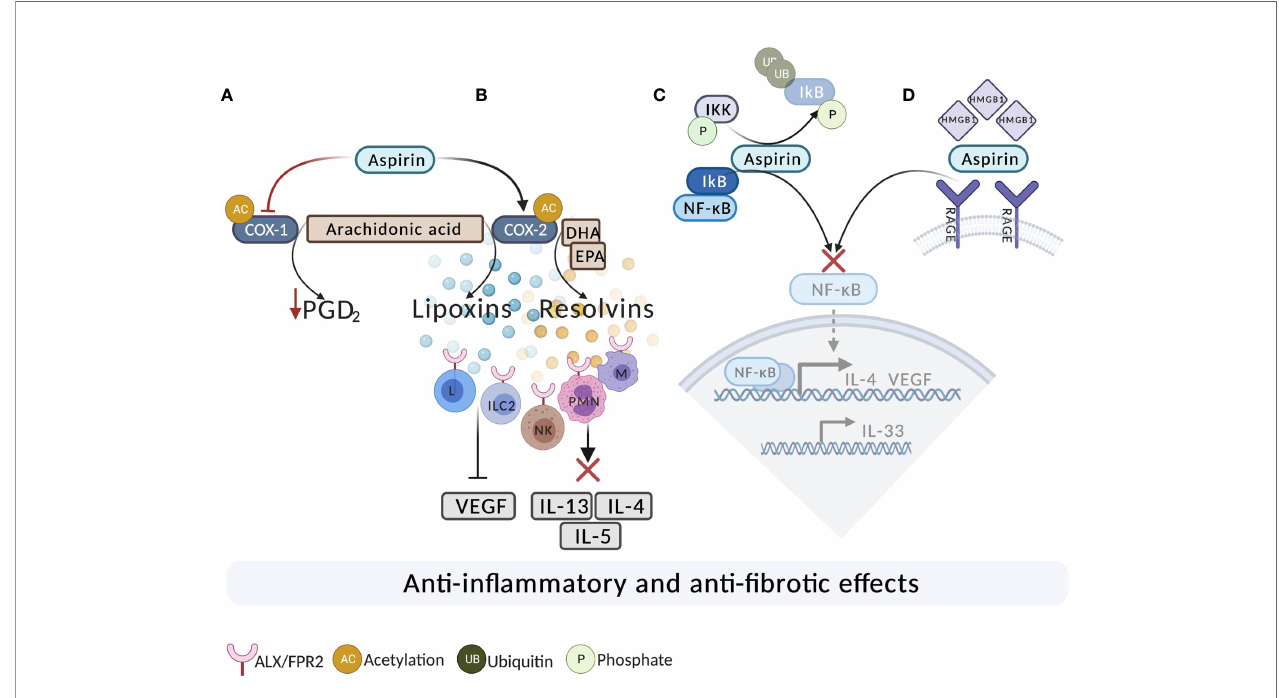
FIGURE 1 | The potential mechanisms of aspirin action in N-ERD. (A) Aspirin acetylates and completely inhibits COX-1. As a result of long-term, high-dose aspirin treatment, there is a reduction in the level of PGD 2 . (B) Aspirin acetylates COX-2. Acetylation of COX-2 results in the production of 15(R)-HETE, leading to generation of 15-epi-lipoxins from arachidonic acid and resolvins from DHA and EPA. Lipoxins and resolvins bind to ALX/FPR2 on ILC2, T, B, and NK cells leading to decreased in fl ammation.Lipoxins also exert anti fi broticeffects byreducing the expression of VEGF. Resolvins act onALX/FPR2 onmacrophages andPMN and promote the resolution of the allergicreaction. (C) Aspirin may inhibit the activation of NF- k B.Aspirinpotentially binds to IKK- b (I k B Kinase) and inhibits the degradation ofI k B, resulting in inhibition of the NF- k B pathway. (D) Inhibition ofhighmobility groupbox 1 protein (HMGB1). Aspirindirectlybinds and inhibits HMGB1 andsubsequently leadsto the inhibition of the downstream pro-in fl ammatory activatingsignaling pathway via NF- ĸ B. DHA, Docosahexaenoicacid; EPA, Eicosapentaenoicacid;ILC2, innatelymphoid type 2 cells; M, macrophage; L,lymphocyte; NK. Natural Killer;PMN, Polymorphonuclear; UB, ubiquitin; P,